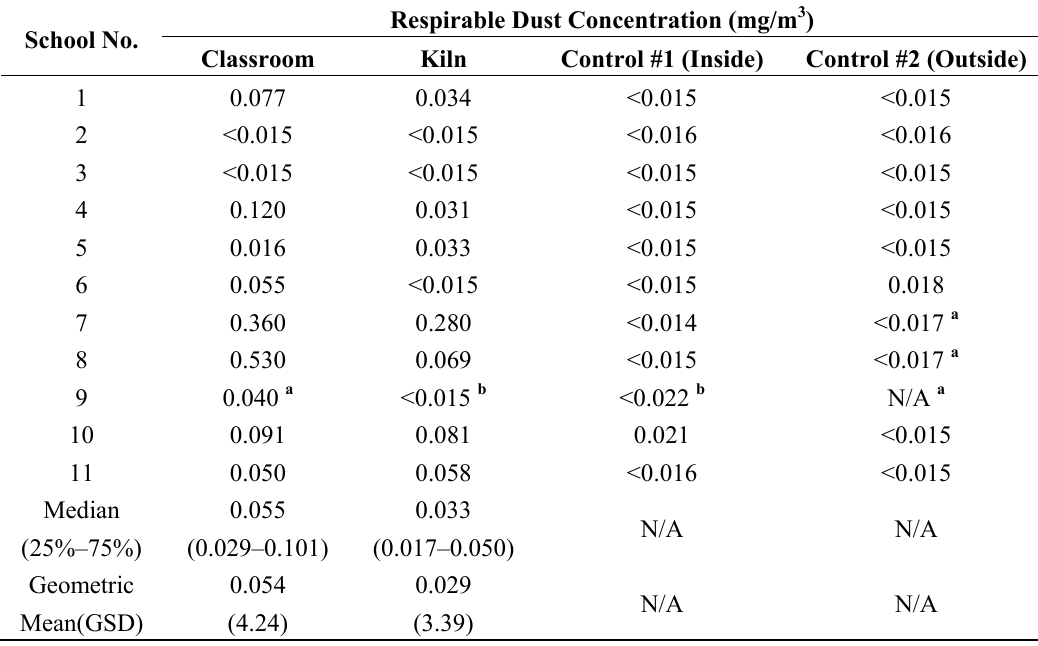
Table 1. Summary of results for respirable dust concentrations by